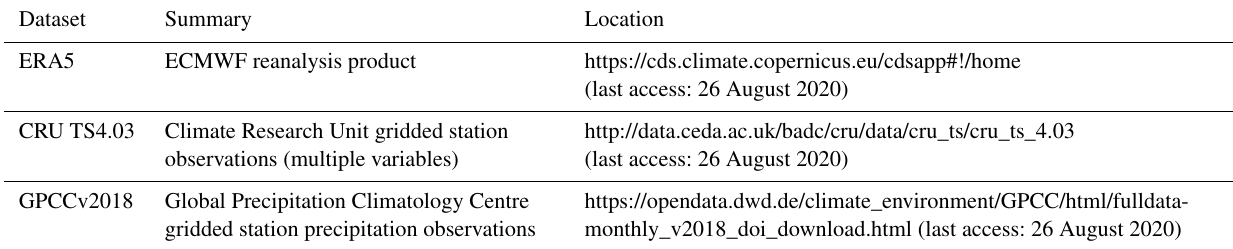
Table 1. Sources of data used to derive the WFDE5